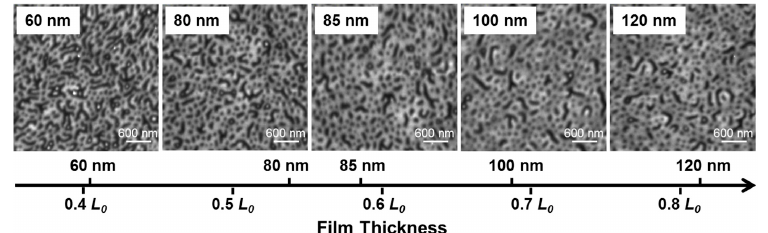
Figure 4. AFM surface height profiles of PS- b -P2VP thin films with different thicknesses annealed under toluene vapor atmosphere at 50 °C for 3 h.